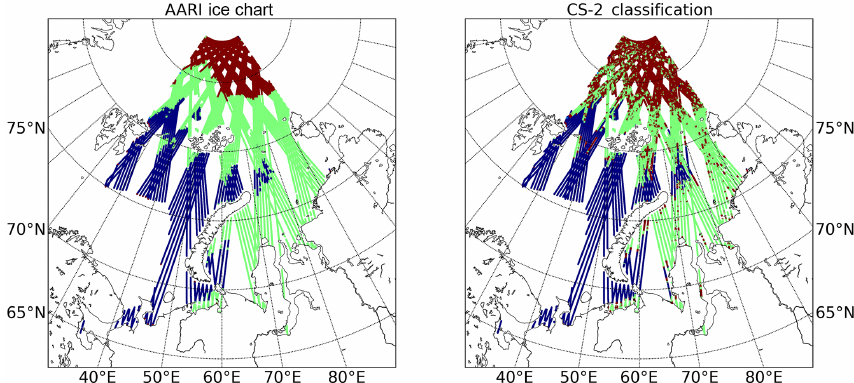
Figure 5. Automatic classification test for November 2013. AARI ice chart SA sampled at CS-2 footprints (left panel) and the classification result from CS-2 measurements (right panel). 15–30 November 2013. Blue: open ocean; green: FY < 70cm; and red: MY.